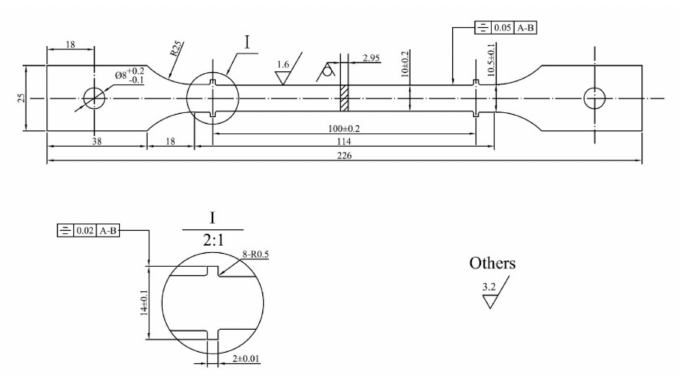
Figure 1. Configuration and dimensions of the specimen for constant-load creep tests (Units: mm).